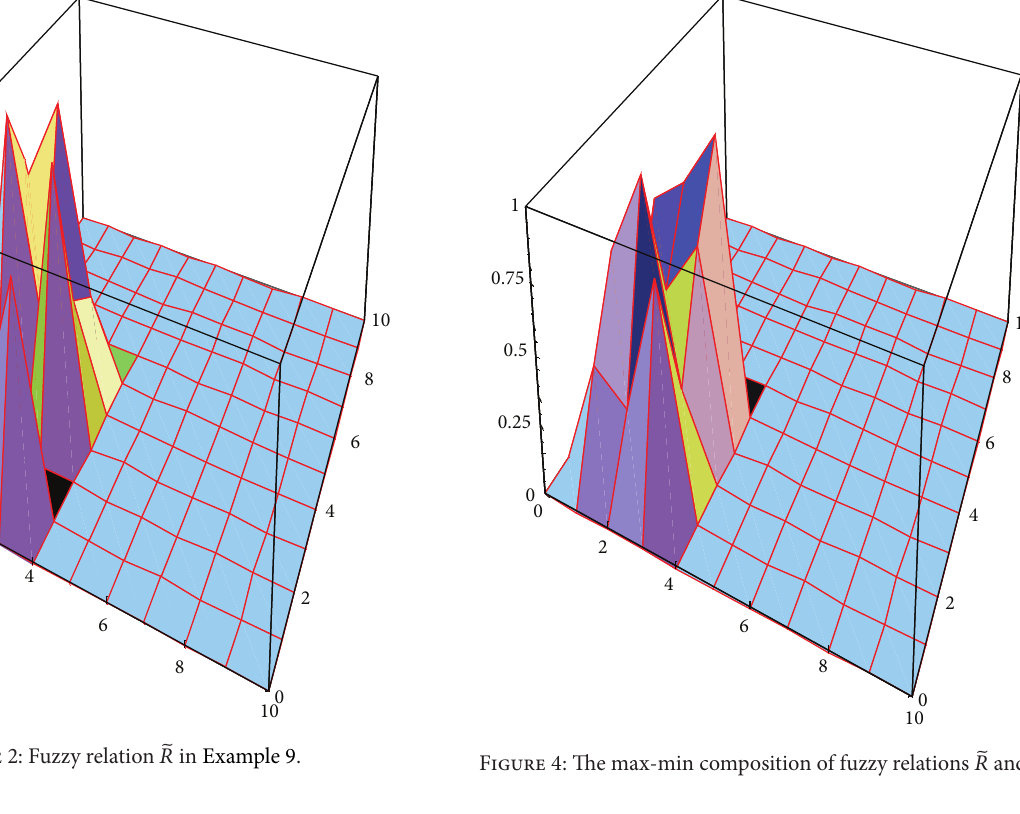
Figure 4: The max-min composition of fuzzy relations